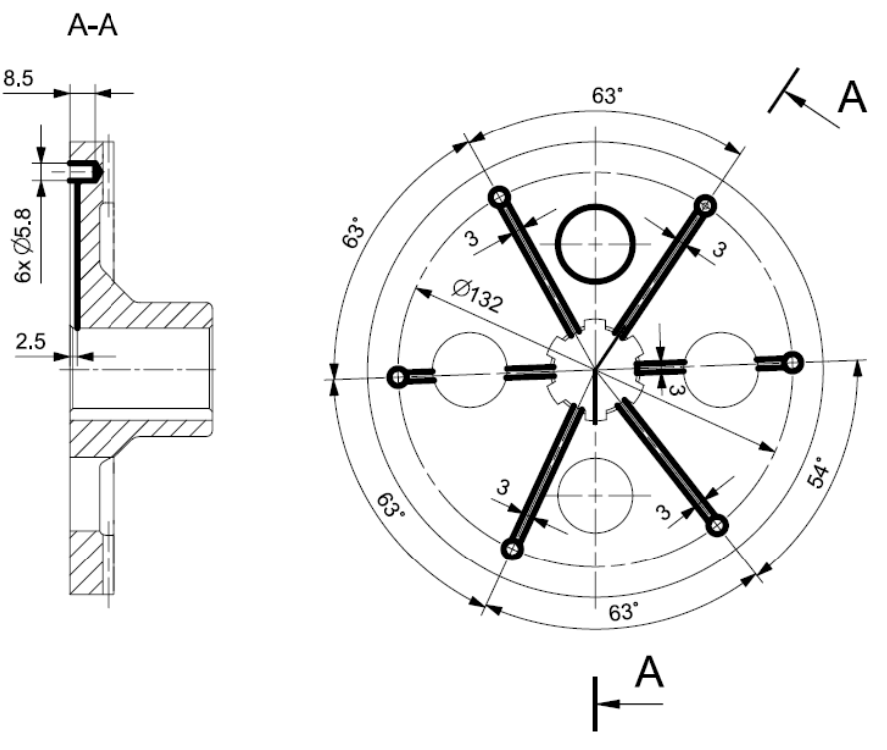
Figure 10. Location of sensors measuring the temperature of the face gear tooth in spiroid gear.